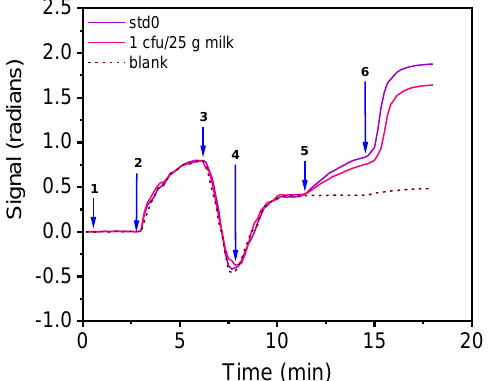
Figure 7. Real-time immunosensor responses when running a zero calibrator over the chip prepared in 10% milk in peptone water (purple line) and a milk sample initially containing 1 cfu of E. coli /25 g milk (pink line) after 7.5 h pre-enrichment. The arrows indicate the sequence of solutions passing over the chip: assay buffer (arrow 1 to 2), zero calibrator/sample in 10% milk in peptone water (arrow 2 to 3), washing (arrow 3 to 4), assay buffer (arrow 4 to 5), biotinylated anti-species-specific antibody (arrow 5 to 6) and streptavidin (arrow 6 to end). Dashed line corresponds to non-specific binding signal.